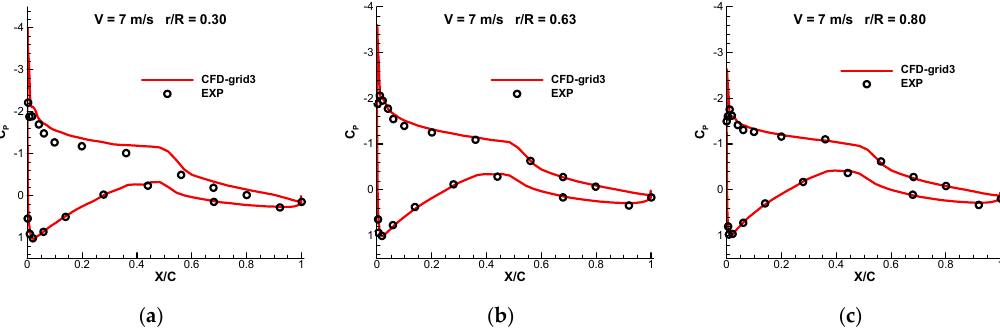
Figure 10. Comparison of pressure distributions between experimental data and present results (wind speed 7 m / s): ( a ) r / R = 0.30; ( b ) r / R = 0.63; ( c ) r / R =